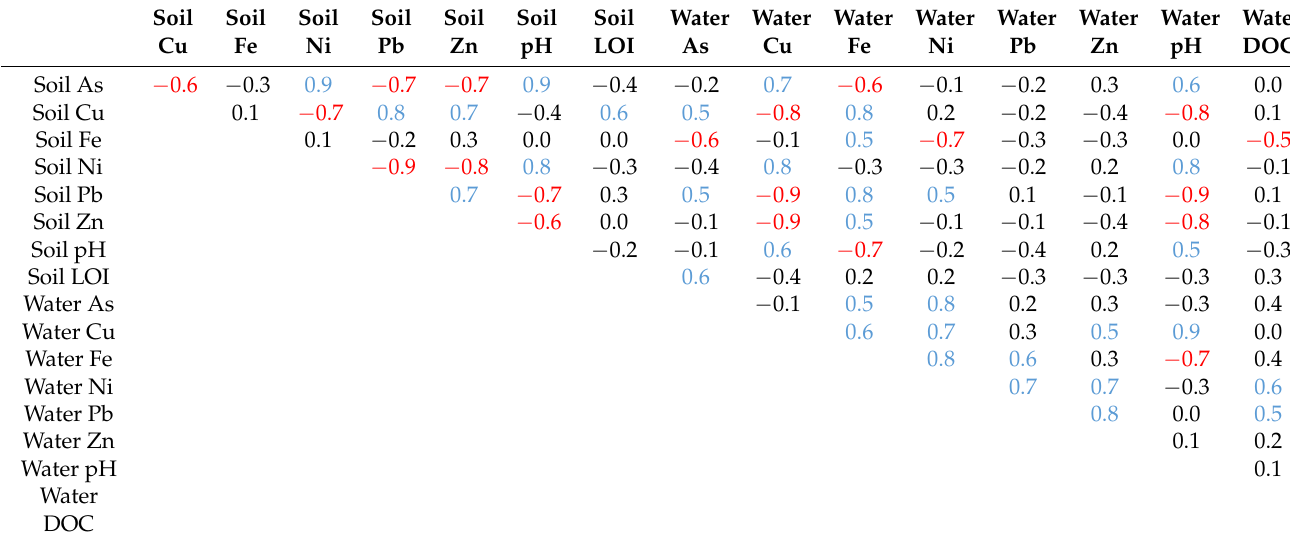
Table 4. Matrix of Pearson’s ( R ) correlation coefficient of trace elements in soil concentrations (abbreviated ‘soil’), soil chemical properties (pH and LOI), normalized dissolved watershed exports (abbreviated ‘water’), and water chemical properties (pH and normalized DOC